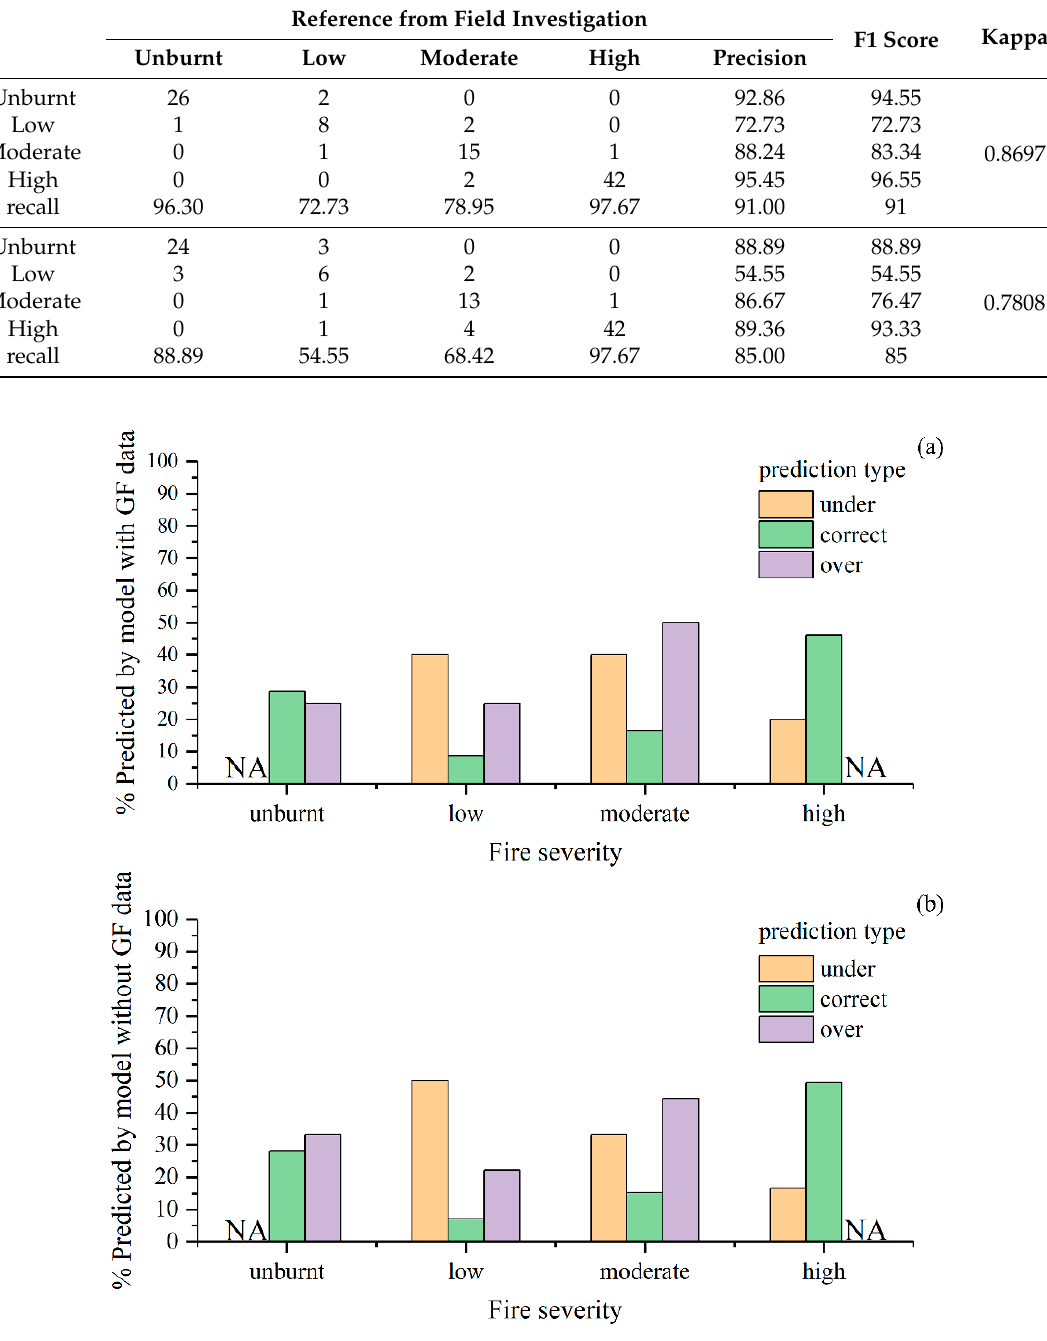
Figure 4. The proportion of validation data across fire severity classes in each prediction type of the S2-GF model ( a ) and the S2 model ( b ); under-predicted (the model predicted a lower severity class compared to the validation data), correctly predicted (the model predicted the same severity class compared to the validation data), and over-predicted (the model predicted a higher severity class compared to the validation data). Unburnt could not be under-predicted and extreme severity could not be over-predicted (i.e., NA).